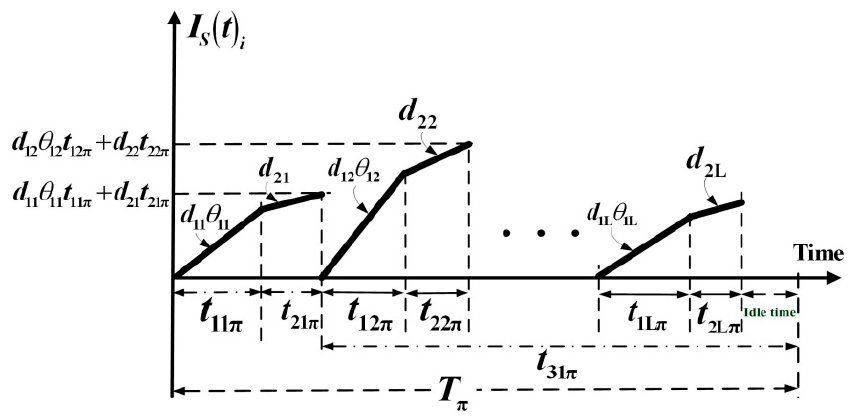
Figure 3. Inventory level of each scrap product i at the manufacturer side of the proposed system. Mathematics 2020 , 8 , x FOR PEER REVIEW